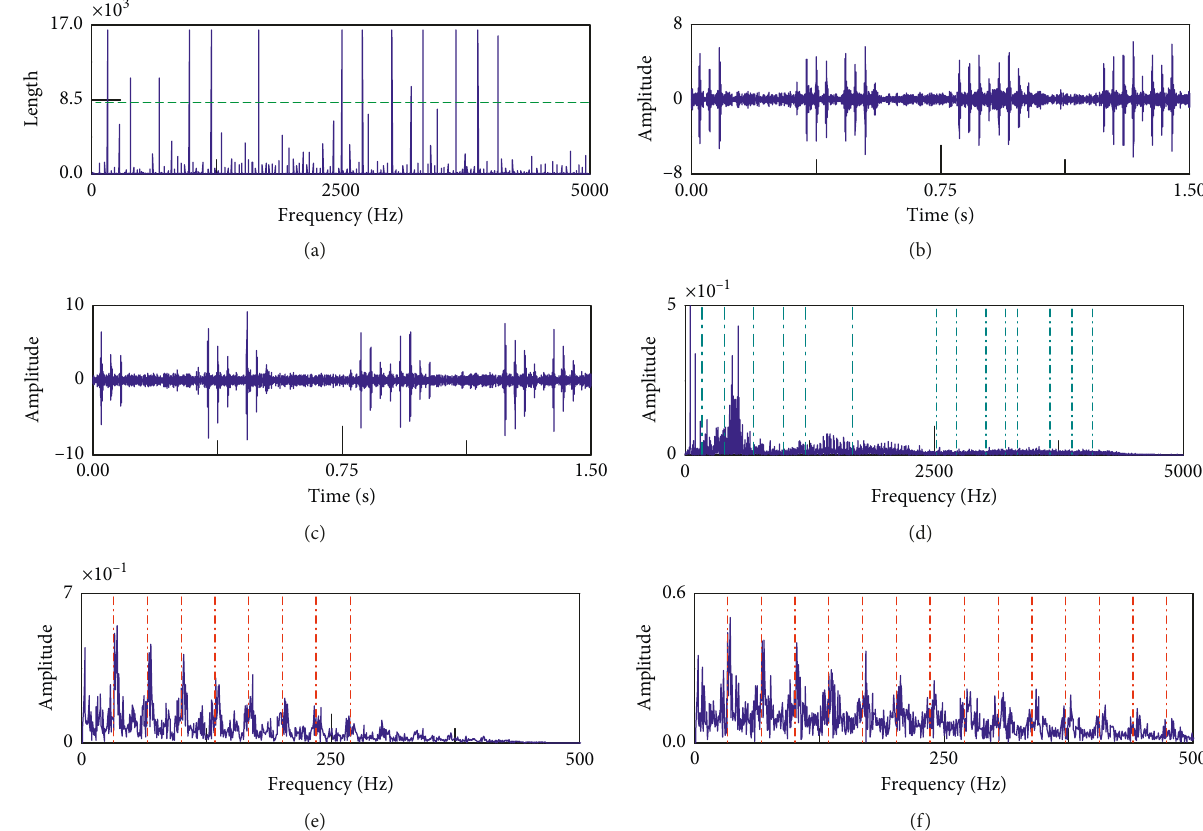
Figure 22: Results obtained by the traditional EWT: (a) SSP (green dashed line: the detected threshold by k -means clustering); (b, c) sub- band signals; (d) detected boundaries (green dash-dotted lines), (e, f) squared envelope spectra (red dash-dotted lines: f BSF and its